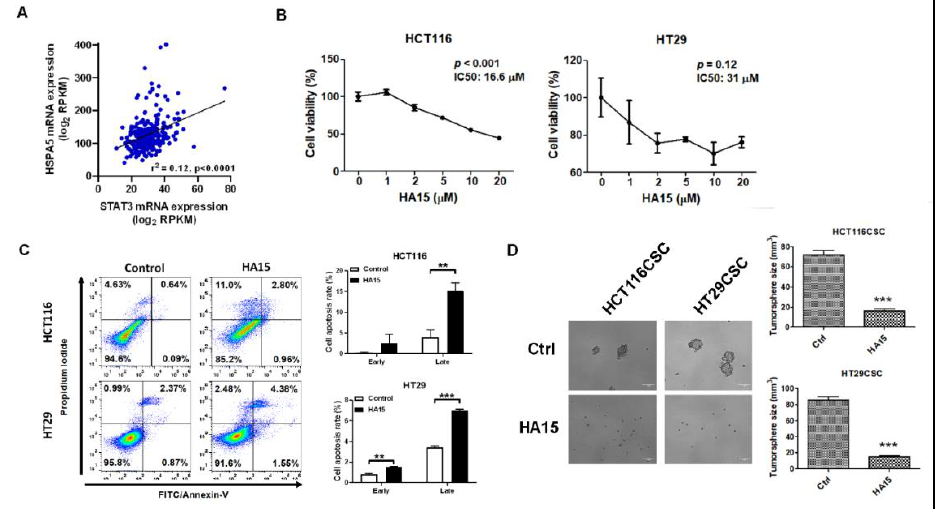
Figure 6. HSPA5 blockade inhibited cancer stemness in CRC cell lines. ( A ) Gene expression correlation of STAT3 and HSPA5 using RNAseq datasets from cBioPortal. Pearson’s correlation coefficient: r = 0.35. ( B ) The HSPA5 inhibitor HA15 significantly reduced cell viability and ( C ) induced cell apoptosis in HCT116 and HT29 cells. ( D ) Moreover, HA15 inhibited tumorsphere formation in HCT116 and HT29 cells. IC50 concentration of HA15 was used for detecting apoptosis and tumorsphere formation. *** p < 0.001.